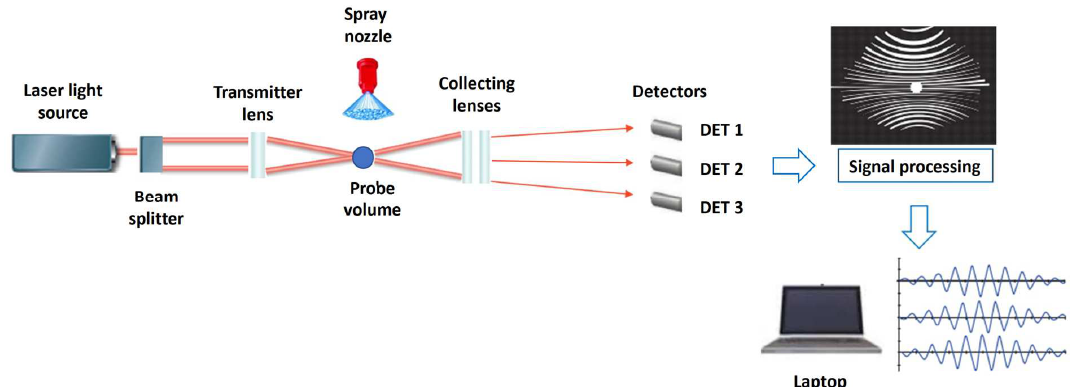
Figure 3. Scheme of PDPA measurement system.